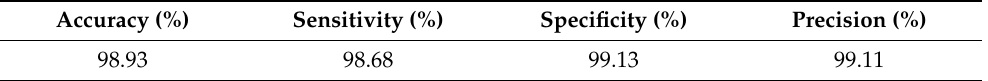
Table 2. Experimental Results of Proposed Transfer Learning based DCNN Model on Figshare dataset.